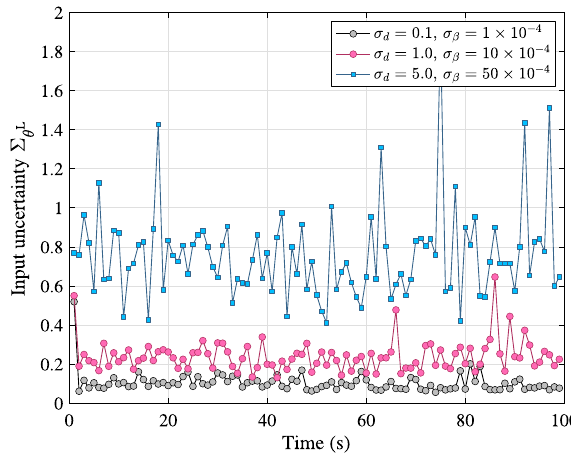
Fig. 7 Input uncertainty with different measurement noise